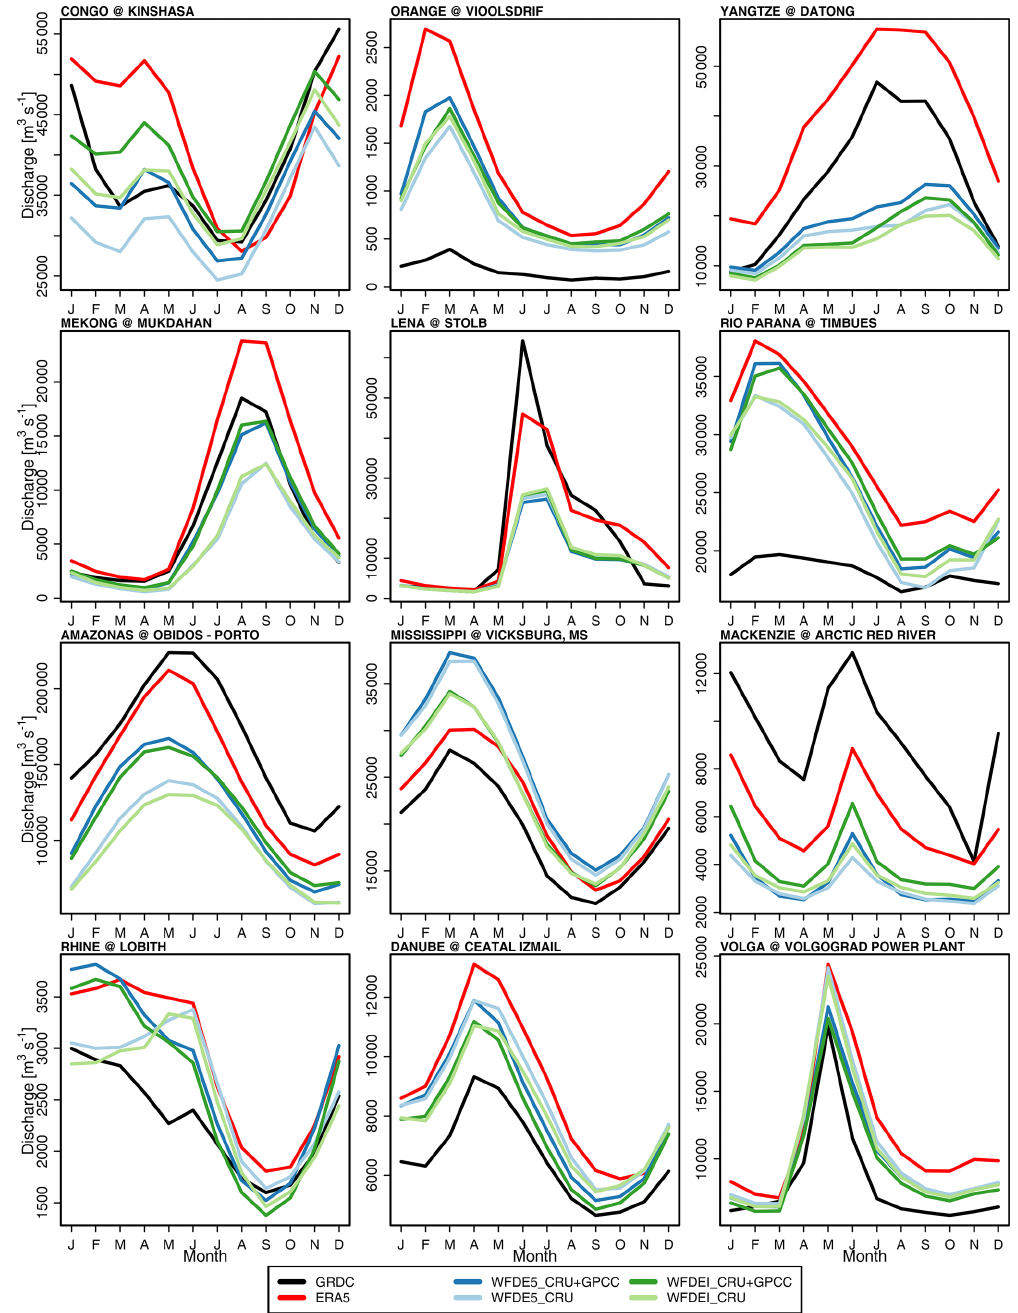
Figure 5. Seasonality of observed river discharge and uncalibrated WaterGAP runs for selected large river basins (Fig. 1).